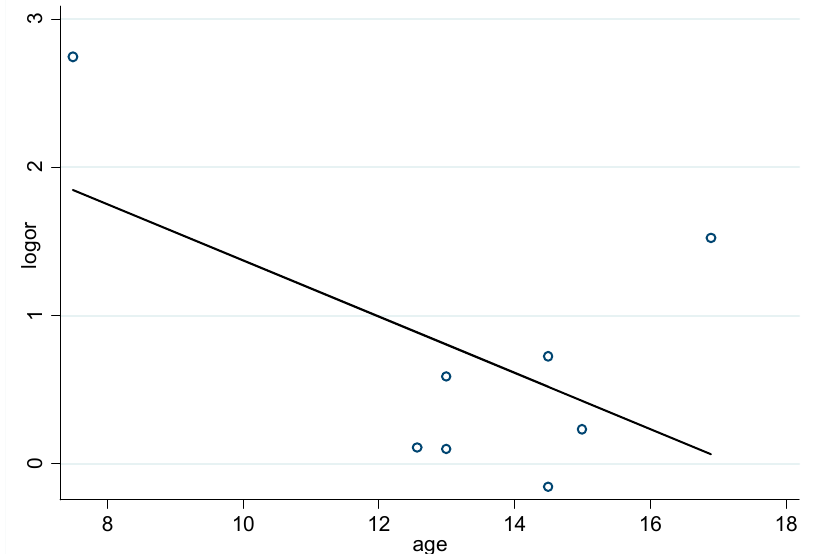
Figure 5. Results of the meta-regression indicated that the OR did not vary significantly with age.